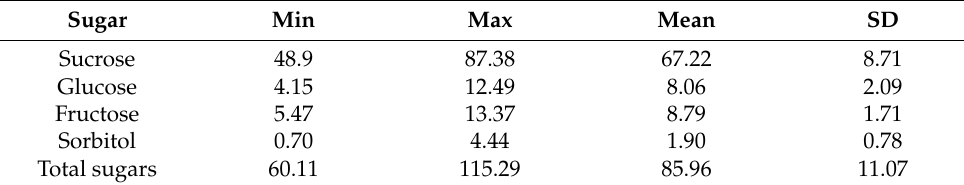
Table 3. Descriptive statistics for the variables of sucrose, glucose, fructose, and total sugars (g kg − 1 FW) of the 84 cultivars studied. For each compound, minimum, maximum, and mean values and standard deviation (SD) are